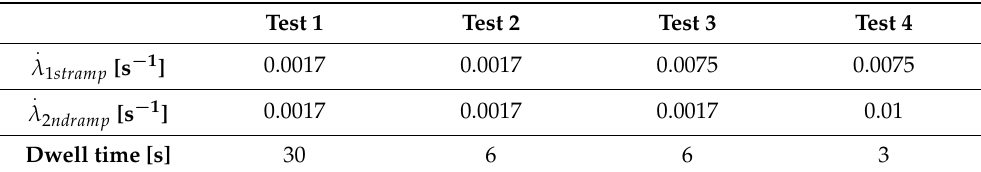
Table 5. Velocity values and dwell time applied during the tests.